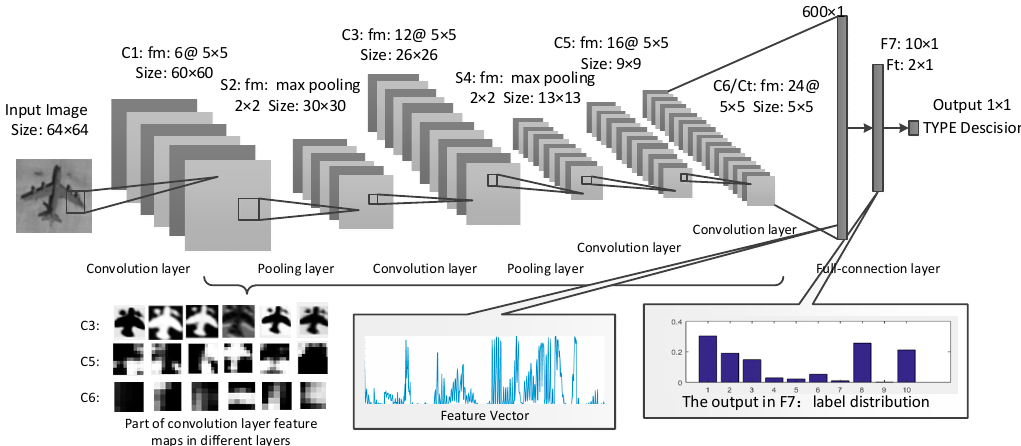
Figure 2. The structure of B_CNN and Trans_CNN.